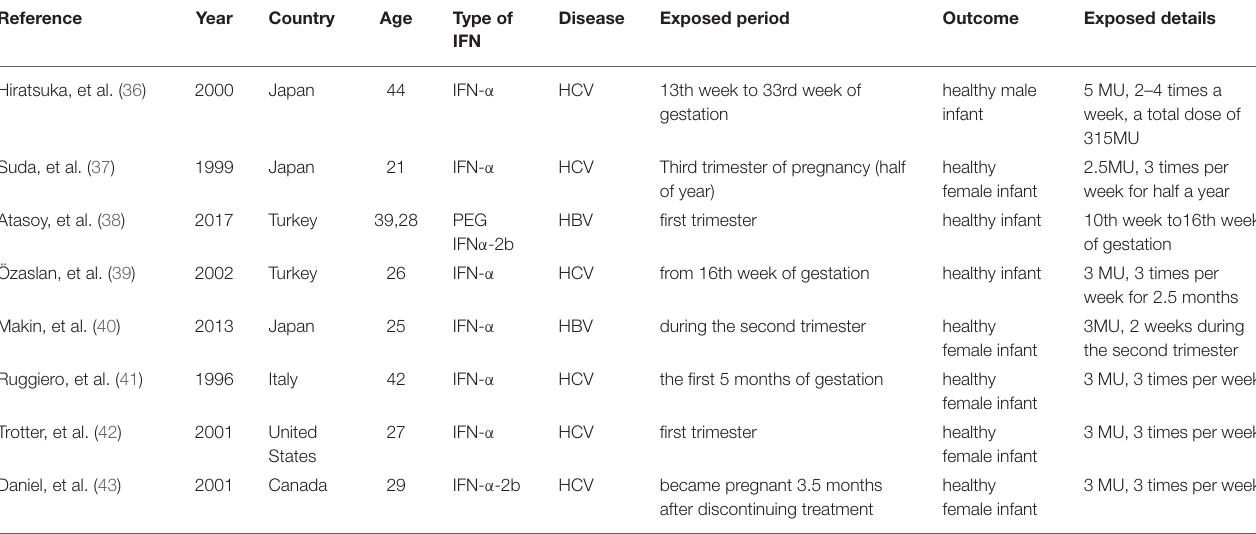
TABLE 2 | Characteristics of cases reported with pregnancy outcomes after IFN- α exposure in patients with viral hepatitis.